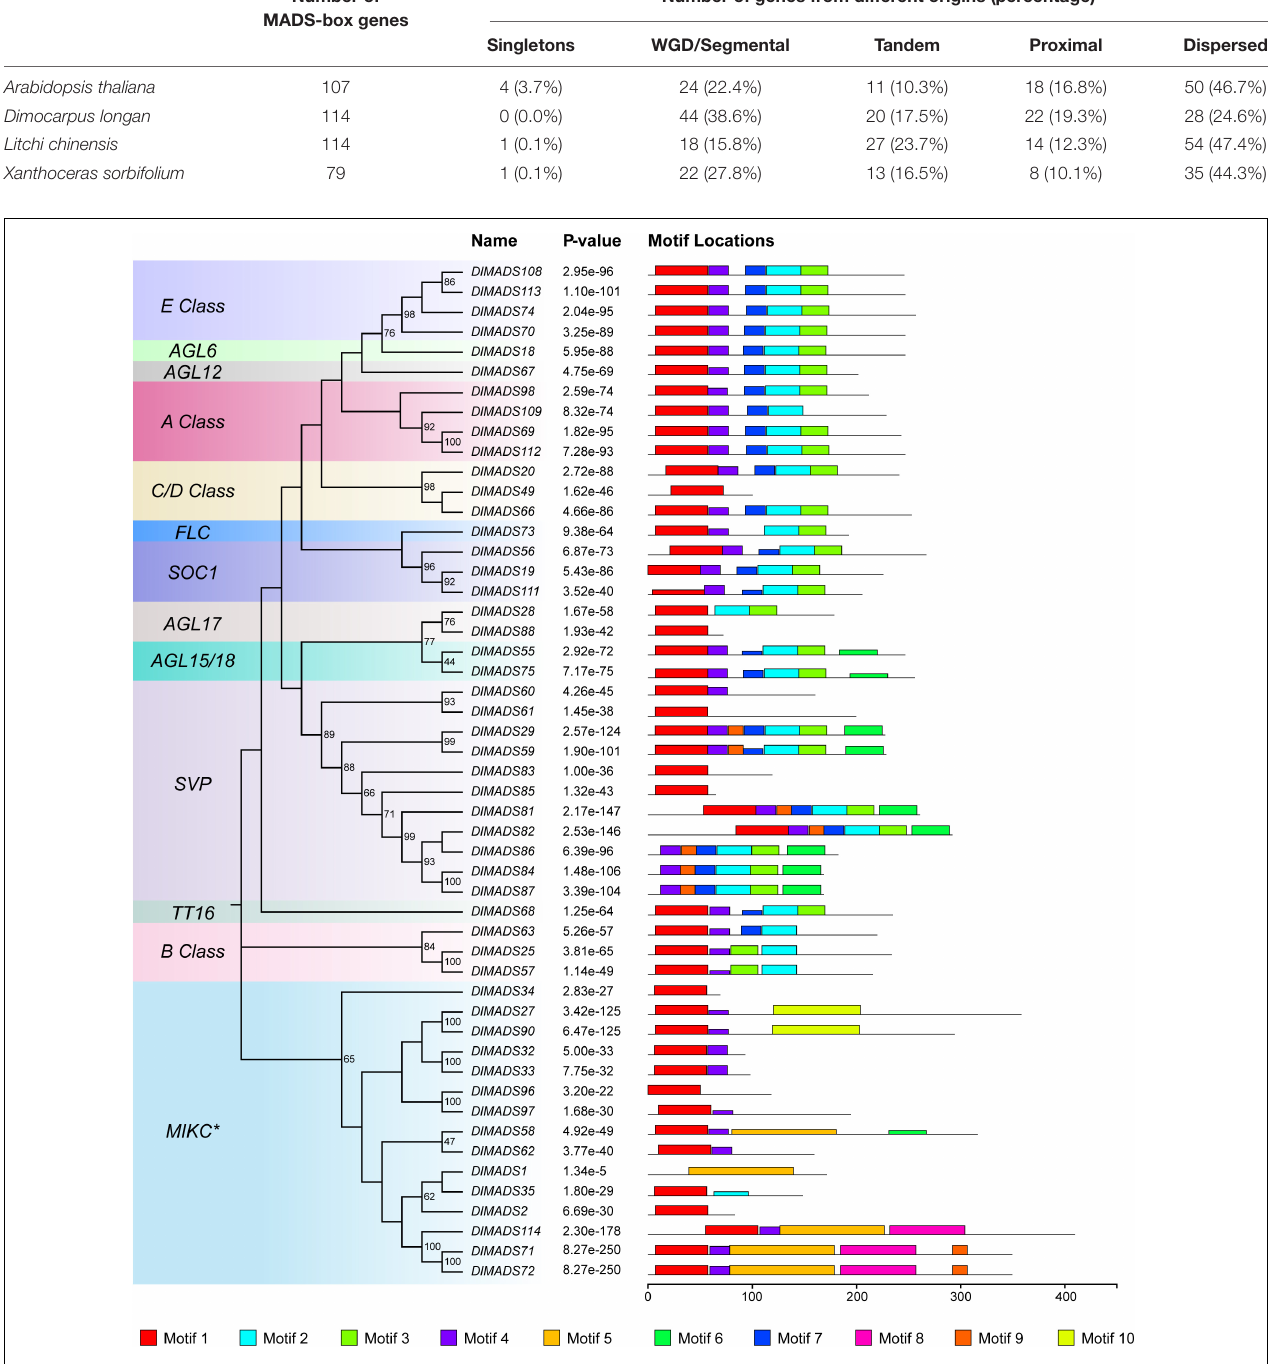
FIGURE 4 | Conserved motif compositions of longan type II MADS-box proteins. The neighbor-joining tree was constructed with the aligned protein sequences of longan type II MADS-box genes. 10 motifs were identified and displayed in different colors.